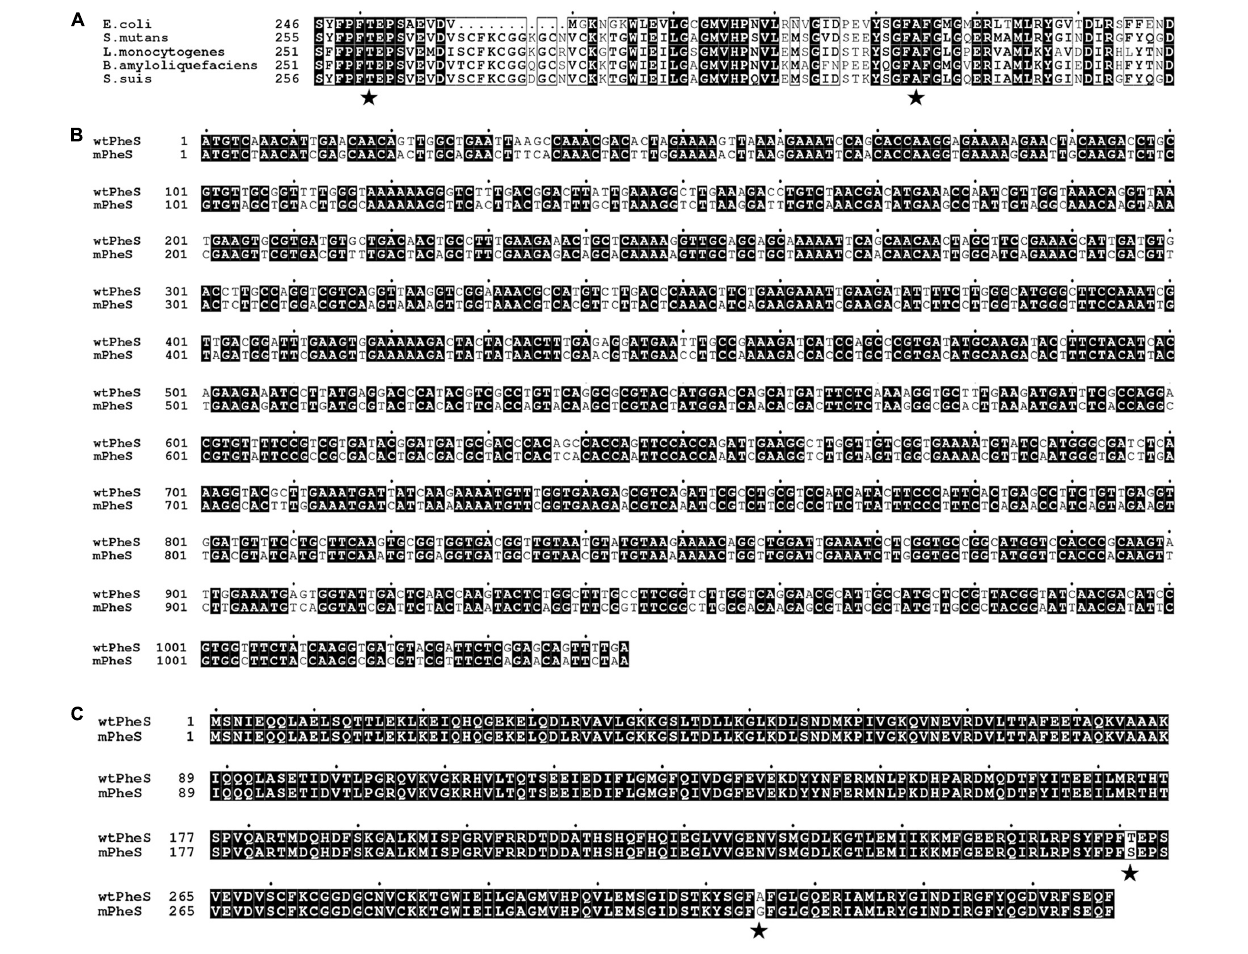
FIGURE 1 | PheS-related sequence alignment. (A) Amino acid sequence alignment of PheS proteins from E. coli , S. mutans , Listeria monocytogenes , Bacillus amyloliquefaciens , and S. suis . The T251 and A294 of PheS from E. coli and corresponding counterparts were indicated by stars. (B) Nucleotide sequence alignment of the wtPheS and mPheS genes. (C) Amino acid sequence alignment of the wtPheS and mPheS proteins. The T261S and A315G substitutions were indicated by